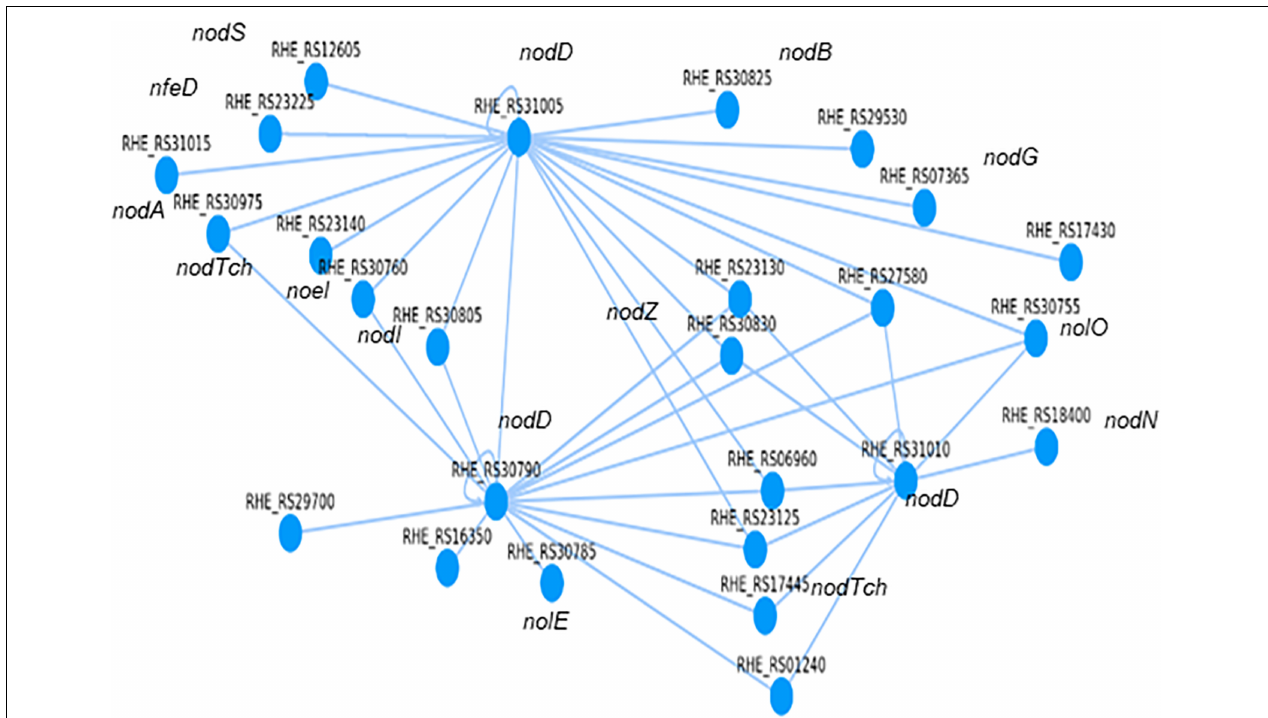
FIGURE 5 | Computational regulatory network for the synthesis of the nodulation factor from R. etli